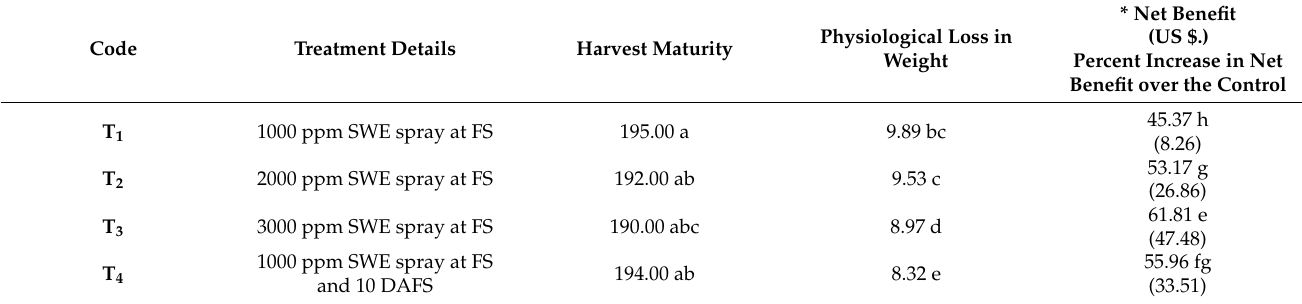
Table 4. Effect of seaweed extract on the net benefit of